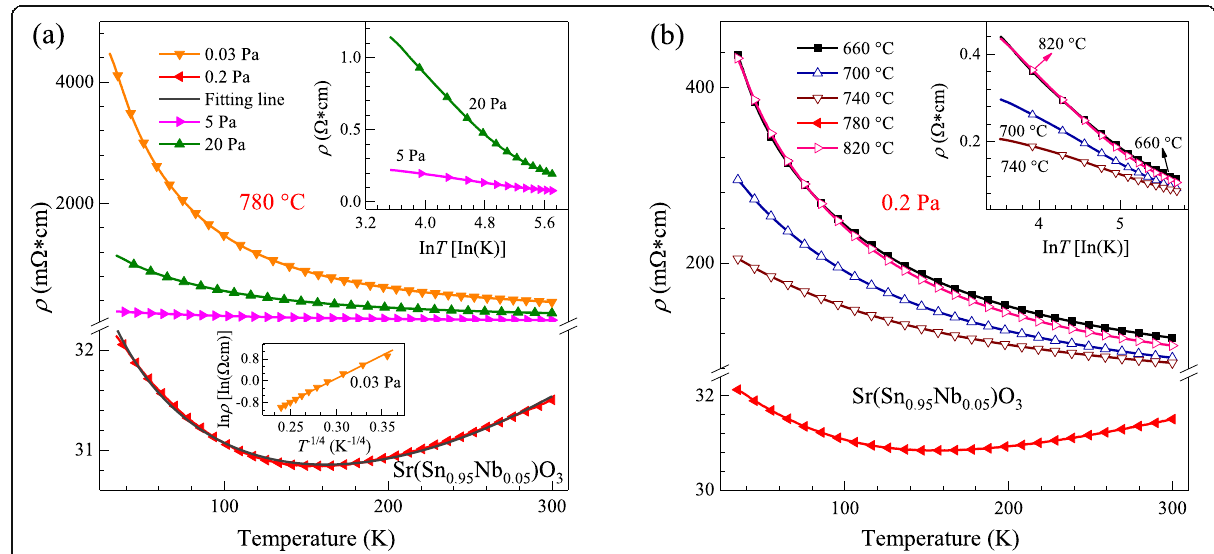
Fig. 5 Temperature dependence of resistivity for the SSNO films grown at various oxygen pressures ( a ) and various substrate temperatures ( b ). The upper inset of a shows the corresponding linear fit results of ρ vs In T , the lower inset the In ρ and T − 1/4 . The inset of b is also the linear relation between ρ and In